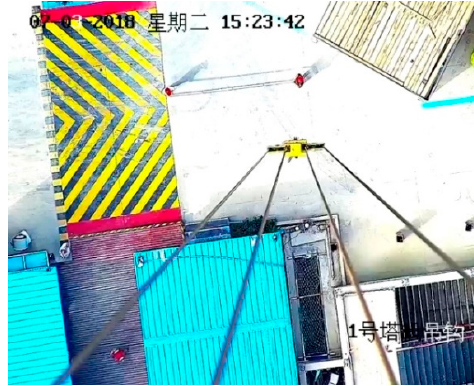
Figure 6. A sample image taken by the tower crane camera at the construction site.